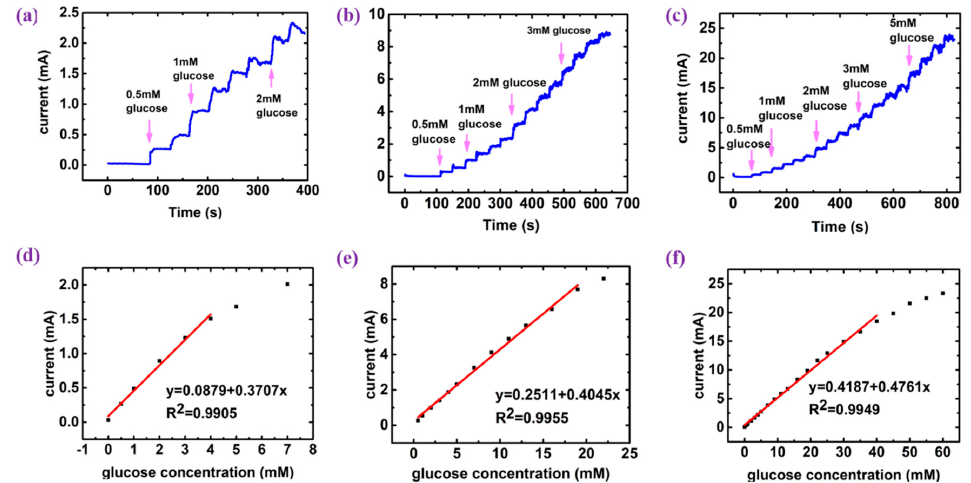
Figure 2. ( a ) The amperometric I-t curve at [OH − ] = 100 mM; ( b ) the amperometric I-t curve at [OH − ] = 1000 mM; ( c ) the amperometric I-t curve at [OH − ] = 500 mM; the linear range concentration of glucose at various OH − concentrations, ( d ) [OH − ] = 100 mM, ( e ) [OH − ] = 500 mM and ( f ) [OH − ] = 1000 mM.